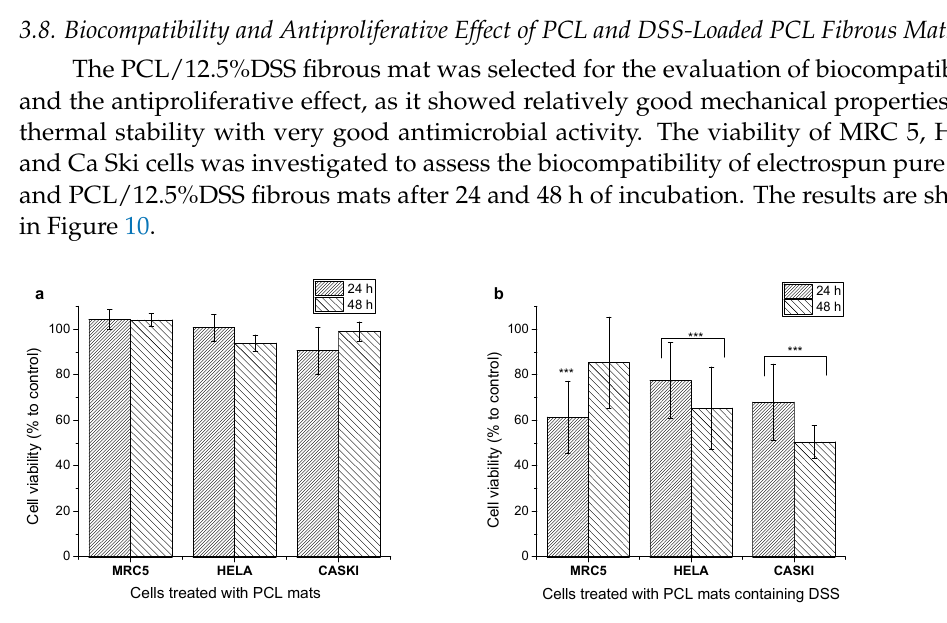
Figure 10. Biocompatibility of PCL mats ( a ) and anticancer activity of PCL mats loaded with DSS ( b ) after 24 h and 48 h incubation time, respectively. Cell viability was determined by MTT assay. The results are presented as mean ± SD (n = 12) of three independent experiments. The statistical significance is shown by asterisks (*** p < 0.001).